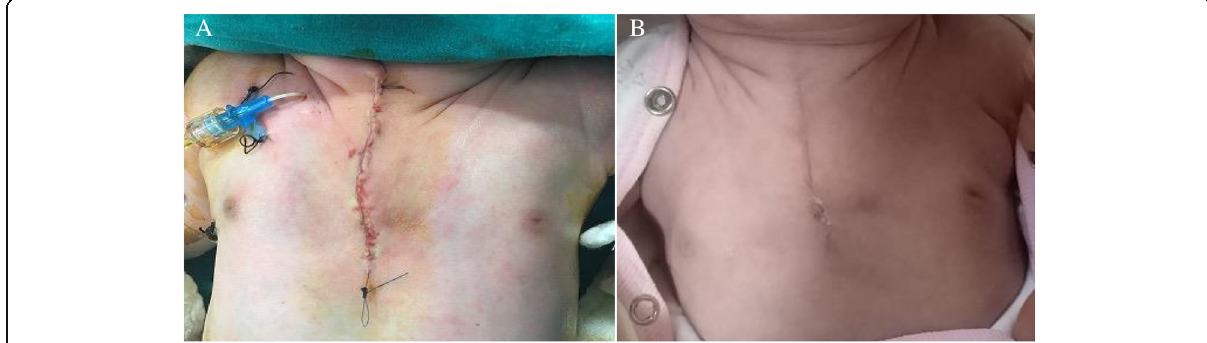
Fig. 4 A Fibrotic skin tissue was excised, and the skin was closed. B The first year of the follow-up is uneventful, and sternal bars have not